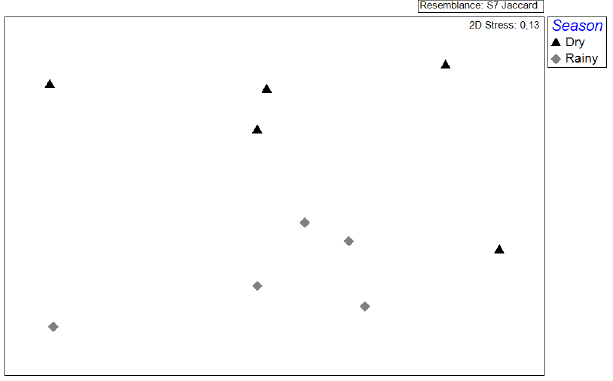
Fig 1. Non-metric multi-dimensional scaling ordination of similarity of lichen diversity ingested by Constrictotermes cyphergaster in the dry (2012) and rainy (2013) seasons in the Semiarid Region of Northeastern